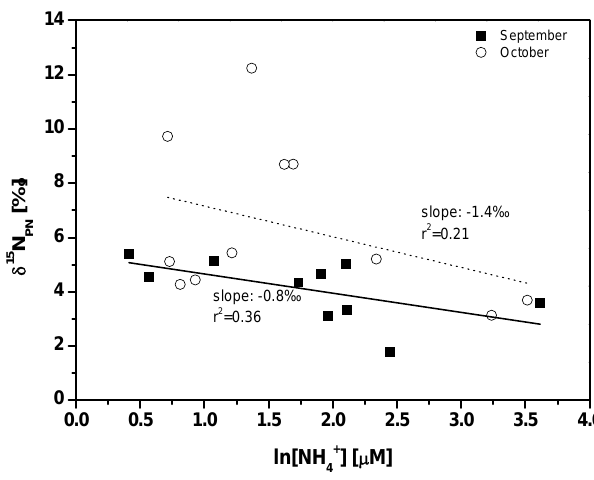
Fig. 5. Dependence of δ 15 N PN values on the natural logarithm of ammonium concentration (ln[NH + ]). The lines indicate the lin- 4 ear regression during ammonium utilization with isotope effects of ε = − 0.8 and − 1.4 in September and October